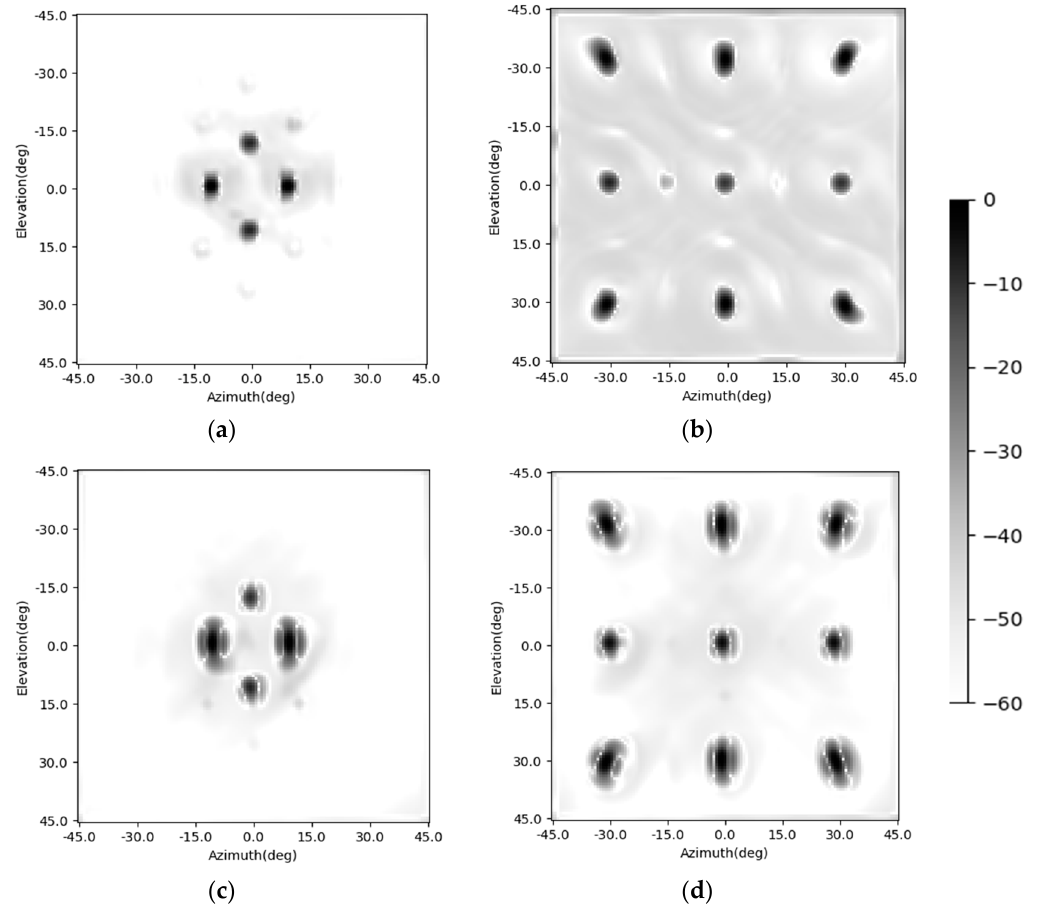
Figure 13. Enhancing results of the simplified SV-CNNs; ( a , b ) enhancing results of the simplified SV-CNN trained using samples with four-channel complementary position-coding; ( c , d ) enhancing results of the simplified SV-CNN trained using samples with four-channel orthogonal position-coding.